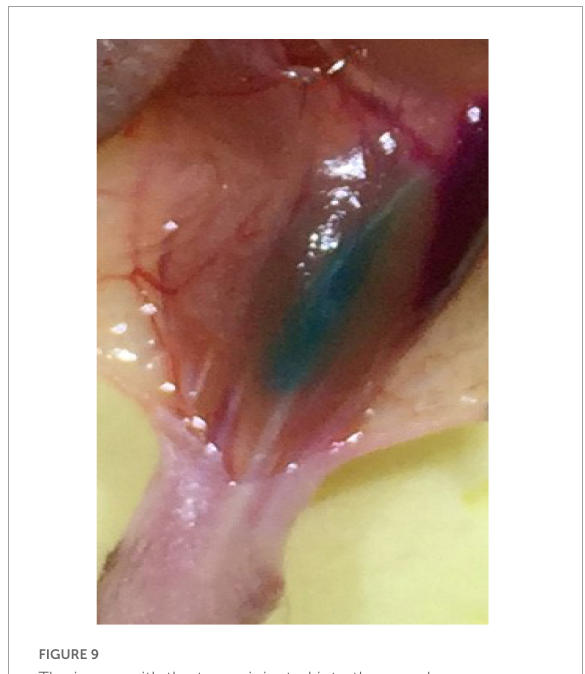
FIGURE9 The image with the tracer injected into the muscle.